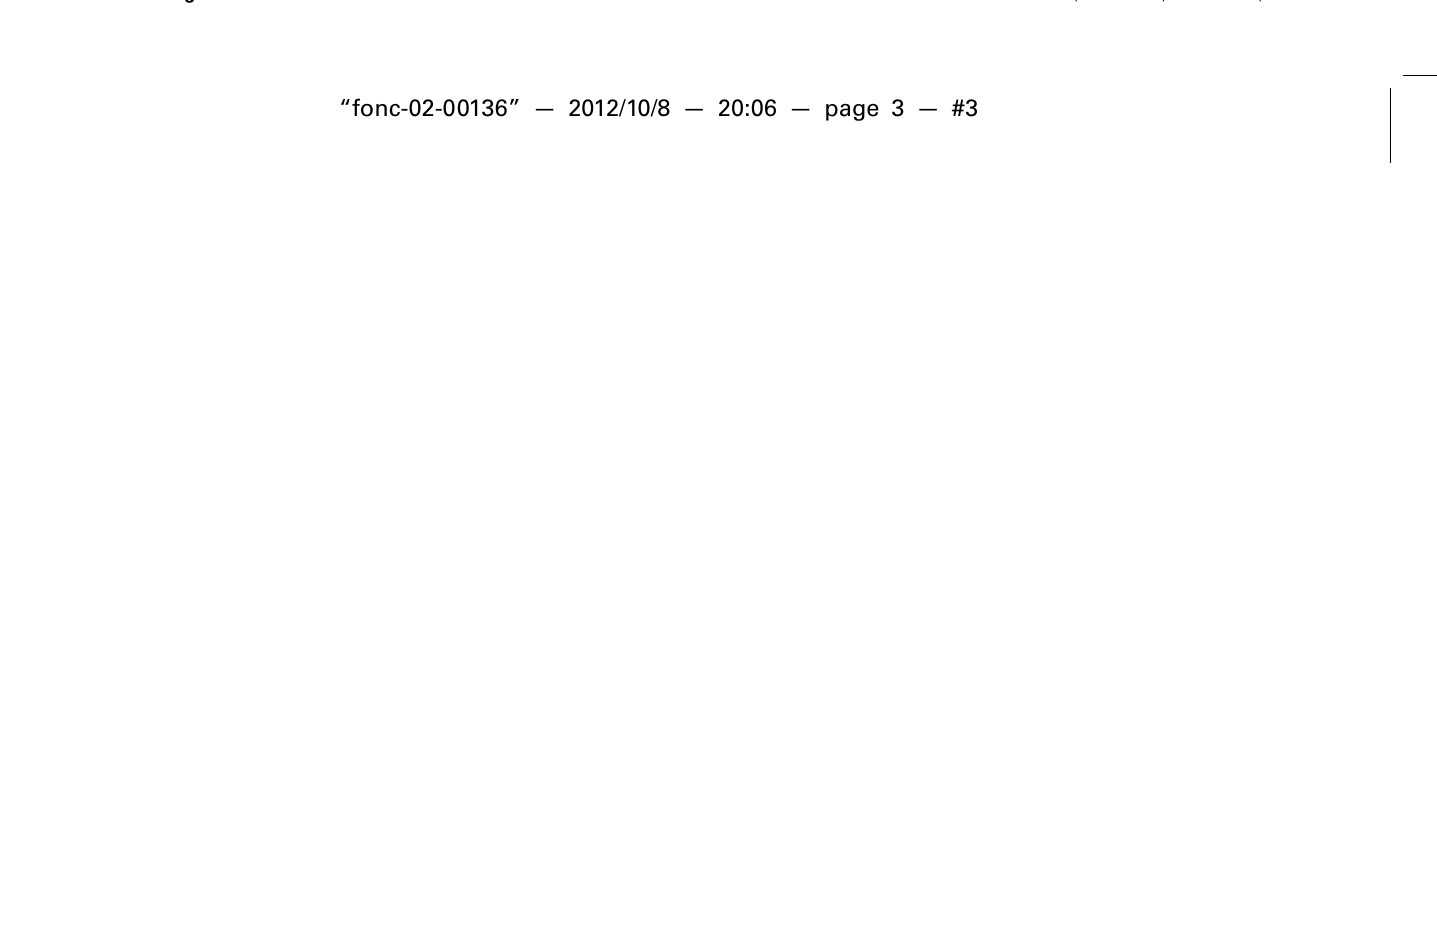
FIGURE 2 |Antigen presentation via major histocompatibility complex class I. Pathogen-derived or self-proteins within the cytosol of antigen presenting cells (APCs) are enzymatically digested into peptides, mainly by cytosolic proteases (proteasomes), and are then transported by transporter associated with antigen processing molecules (TAP) into the